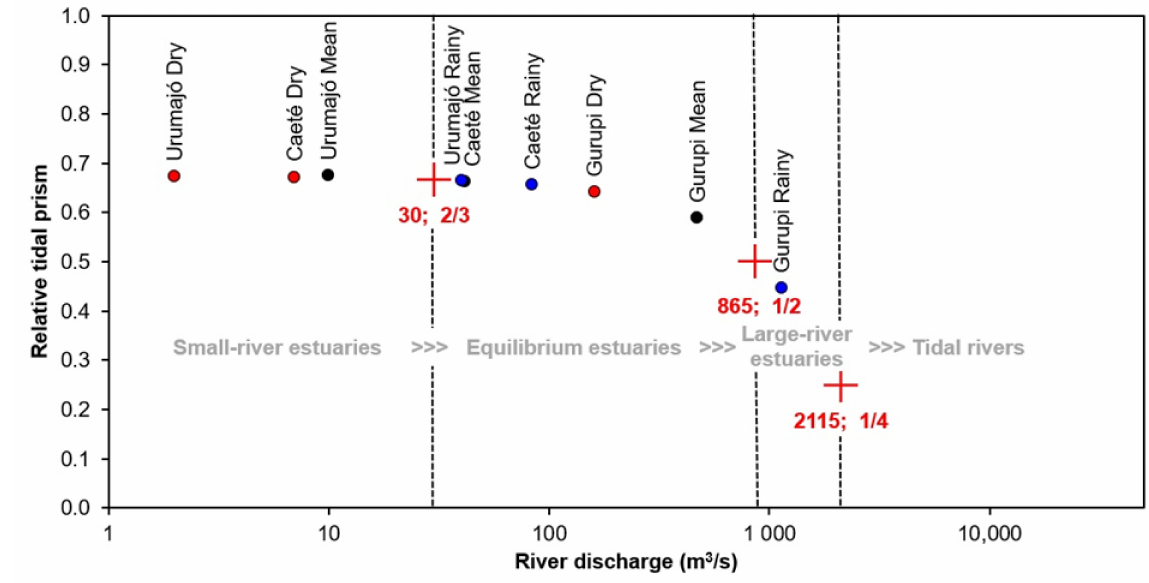
Figure 10. Correlation of relative tidal prism and fluvial discharge of the Gurupi estuary based on the seasonal variations of fluvial discharge, in comparison to the Caet é and Urumaj ó estuaries (data from [18]). The red circles represent the dry season, the blue circles represent the rainy season and the black circles represent the mean river discharge values. River discharge is represented in a logarithmic